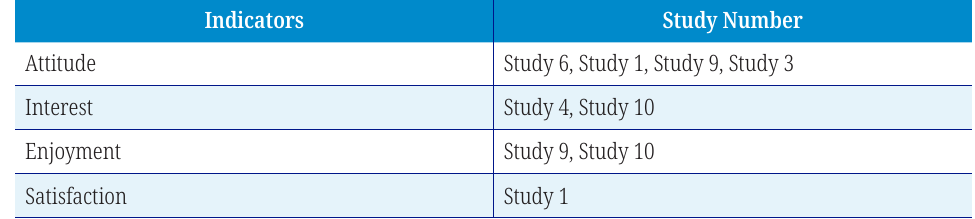
Table 5. Student affective engagement indicators